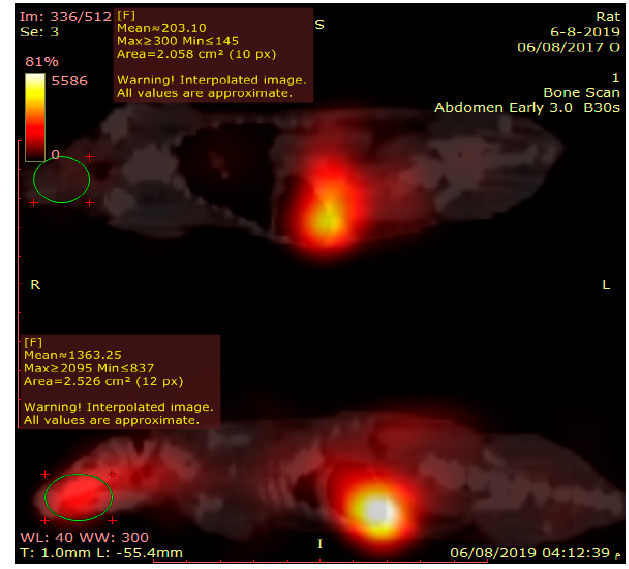
Figure 10. Sagittal view of fused SPECT/CT image of two rats, acquired after 30 min of drug administration. The upper one received Tc-99m labeled temazepam oral suspension; the lower one received Tc-99m labeled temazepam NLC-1 formulation. The region of interest (ROI) drawn on the brain shows higher counts in the lower one.